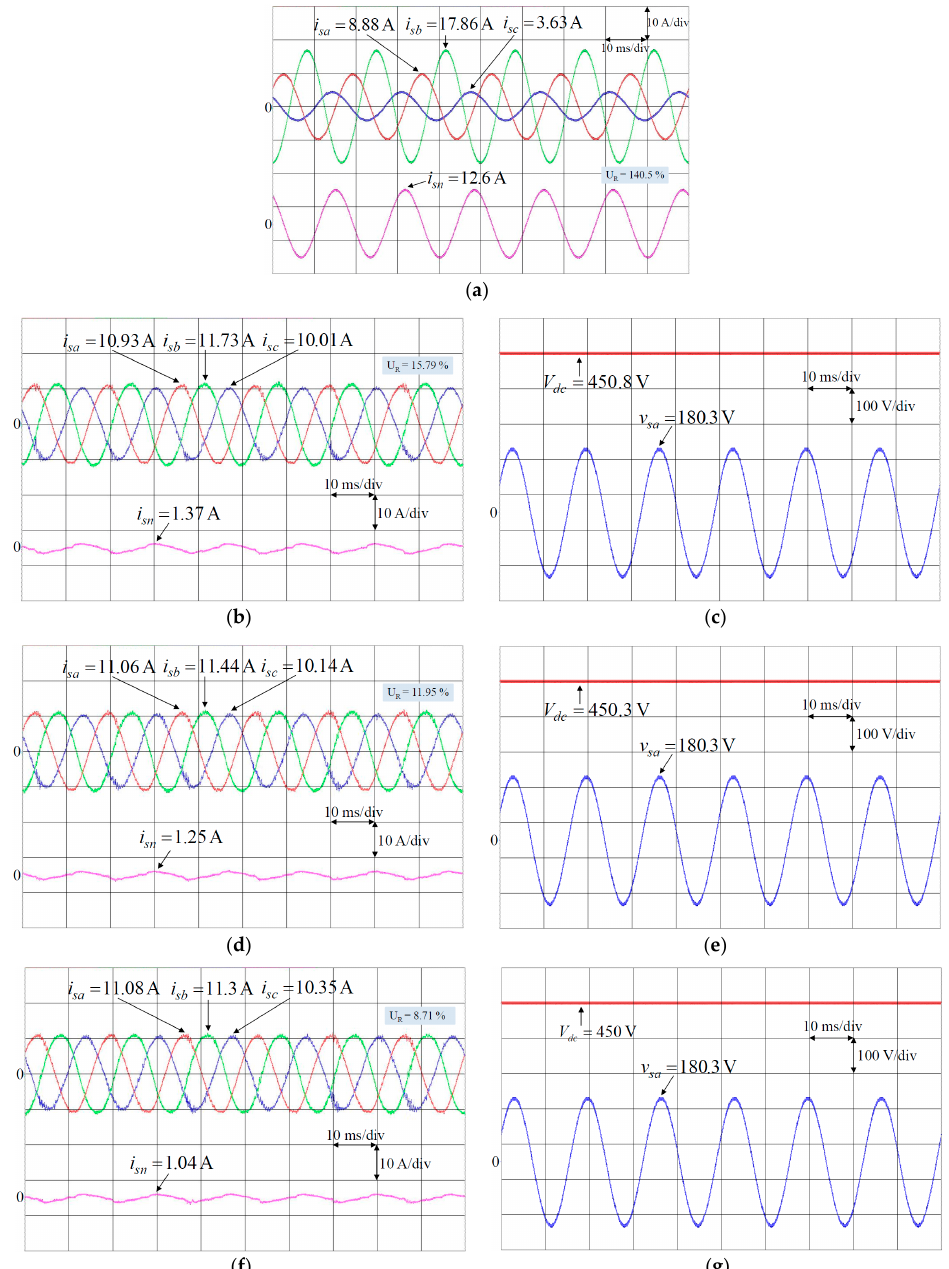
Figure 7. Experimental results at unbalanced load 3: ( a ) Responses of three-phase currents i sa , i sb , i sc and neutral current i sn without using shunt APF; ( b ) Responses of three-phase currents i sa , i sb , i sc and neutral current i sn using PI controlled shunt APF; ( c ) Responses of DC-link voltage V dc and phase voltage of power grid v sa using PI controlled shunt APF; ( d ) Responses of three-phase currents i sa , i sb , i sc and